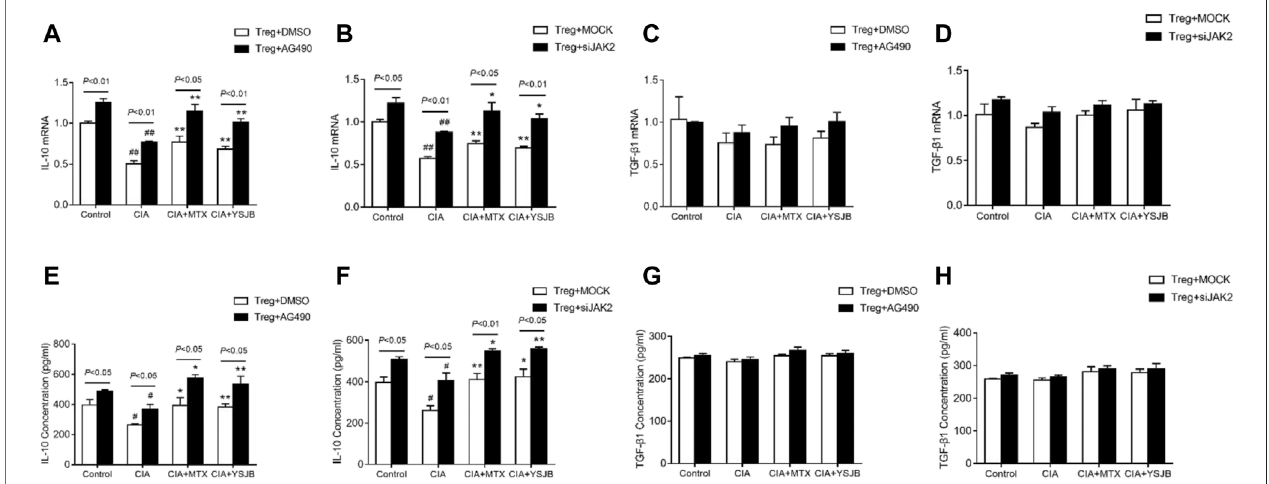
FIGURE 8 | YSJB, AG490 and JAK2 siRNA promoted the secretion of IL-10 by Tregs. The mRNA levels of IL-10 and TGF- β 1 were measured by qRT-PCR (A – D) and ELISA (E – H) in Tregs treated with drug-containing serum, AG490 or JAK2 siRNA. # p < 0.05, ## p < 0.01 compared with the control group; * p < 0.05, ** p < 0.01 compared with the CIA group.